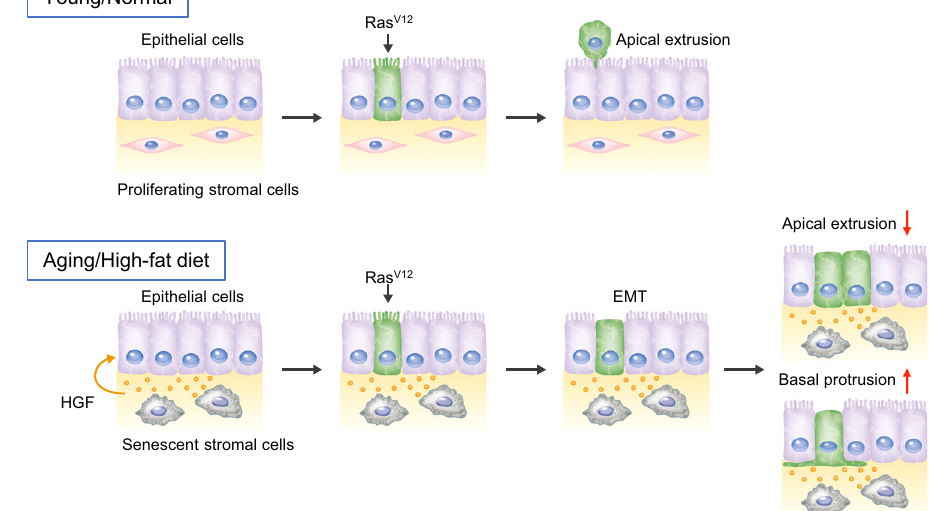
Fig. 6 A model of cell competition in young and aged tissues. In normal tissues, Ras V12 -transformed cells are removed via apical extrusion from epithelial layers. However, senescent cells accumulate in various tissues with aging or consumption of a high-fat diet. Consequently, HGF secreted from senescent stromal cells suppresses apical extrusion and promotes basal protrusion of Ras V12 -transformed cells, leading to abnormal cell proliferation in epithelial layers and in fi ltration to basal layers. Therefore, the decline of cell competition might be etiologically associated with the development of cancer in aged